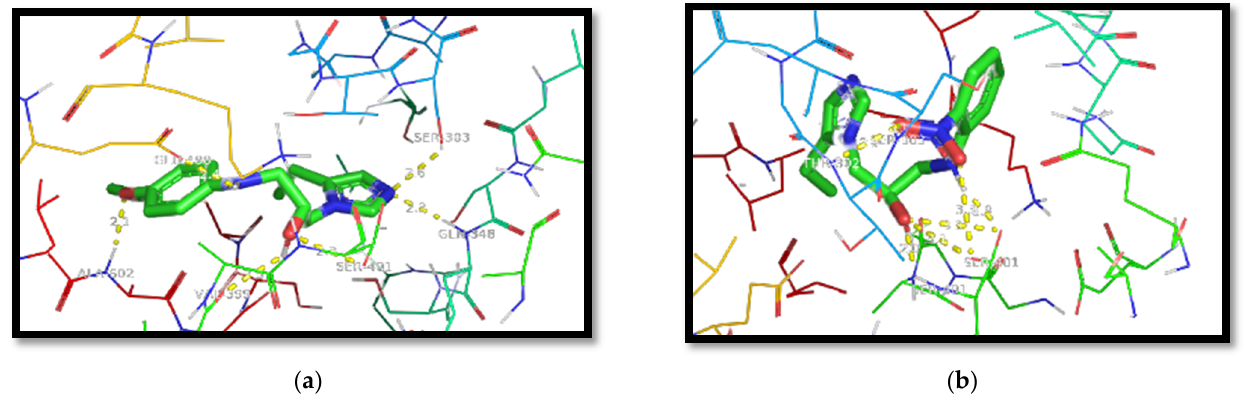
Figure 3. ( a ) Docking of compound 26n in the binding pocket of glucosamine-fructose-6-phosphate synthase (2VF5). Ligand is shown as green line model and the amino acid residues interacting with the ligands are shown as conventional colored line model. Six hydrogen bond interactions (2.4, 2.5, 2.6, 2.2, 2.1, 2.9 Å) with amino acid residues of glucosamine-fructose-6-phosphate synthase are shown in yellow dotted lines. ( b ) Docking of compound 26o in the binding pocket of glucosamine-fructose-6-phosphate synthase (2VF5). Ligand is shown as green line model and the amino acid residues interacting with the ligands are shown as conventional colored line model. Eight hydrogen bond interactions (2.0, 3.3, 3.1, 1.9, 3.3, 2.2, 2.1, 2.9 Å) with amino acid residues of glucosamine-fructose-6-phosphate synthase are shown in yellow dotted lines.